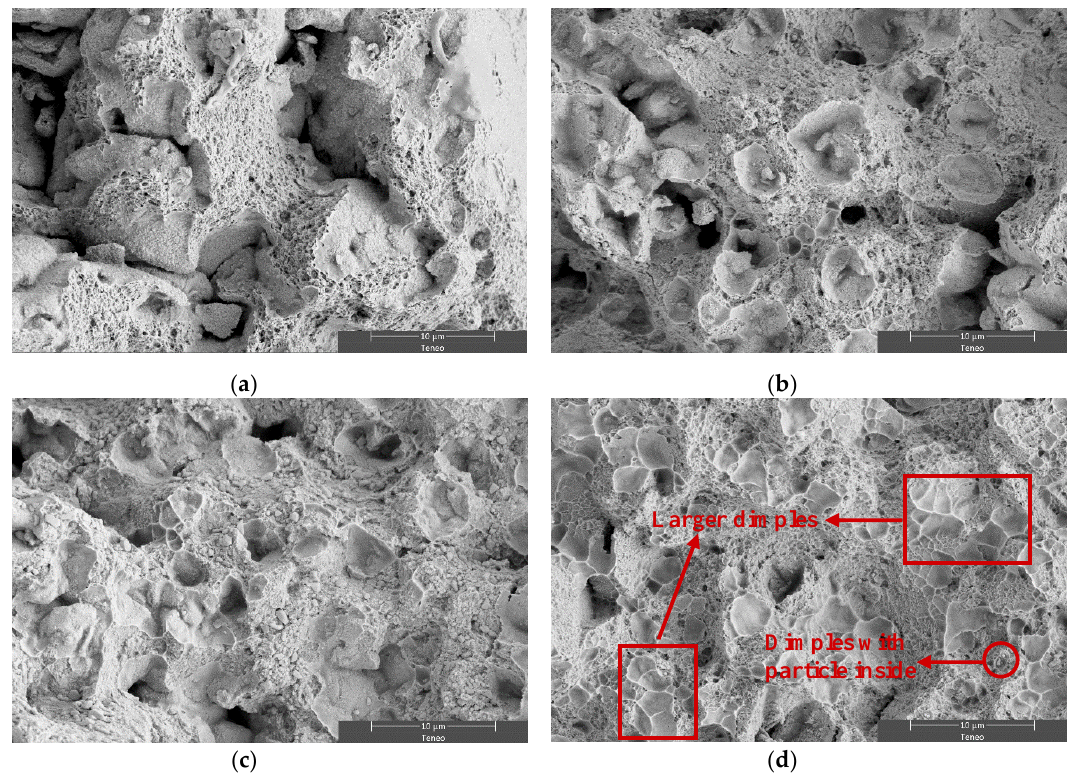
Figure 7. SE-SEM microfractographs of ( a ) V, ( b ) F5, ( c ) F10, and ( d ) C. A tensile test was carried out at 250 ◦